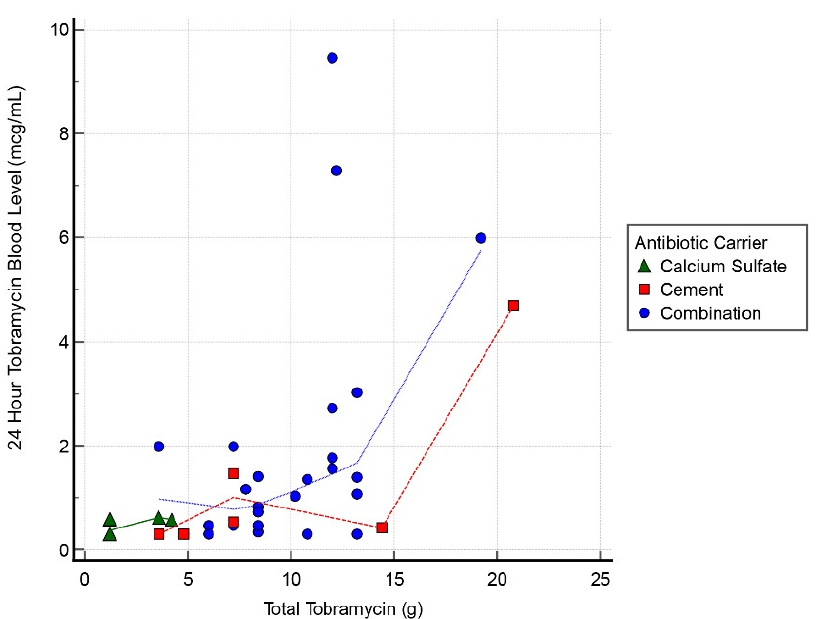
Figure 1. Scatter graph of tobramycin blood level (mcg/mL) and total tobramycin (g) at 24 h interval.